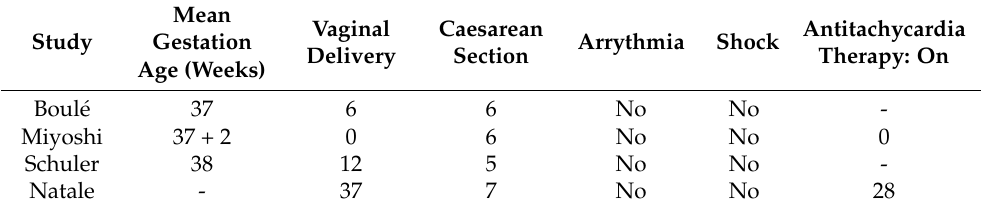
Table 9. The mean gestation age, delivery method, occurrence of ventricular arrhythmia, number of shocks during delivery and activation status of the ICD during delivery, are presented. Mean Vaginal Caesarean Antitachycardia Study Gestation Arrythmia Shock Delivery Section Therapy: Age (Weeks)